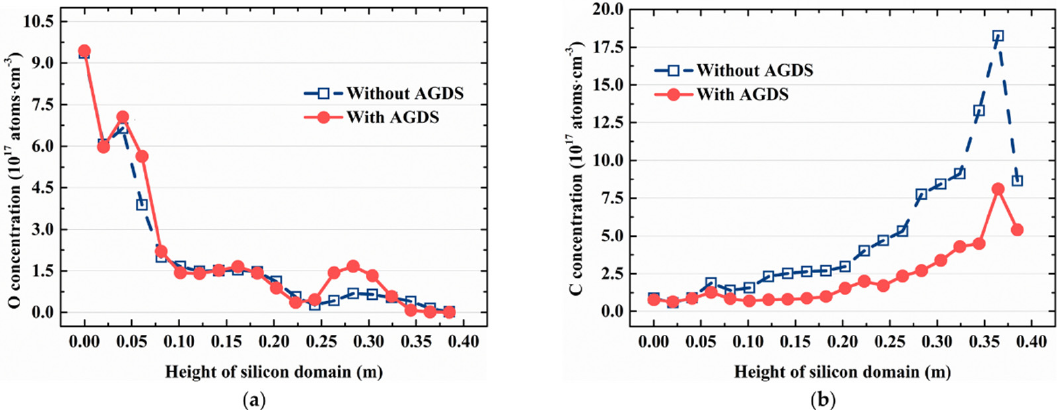
Figure 12. O ( a ) and C ( b ) concentration along the center axis of the silicon ingots.